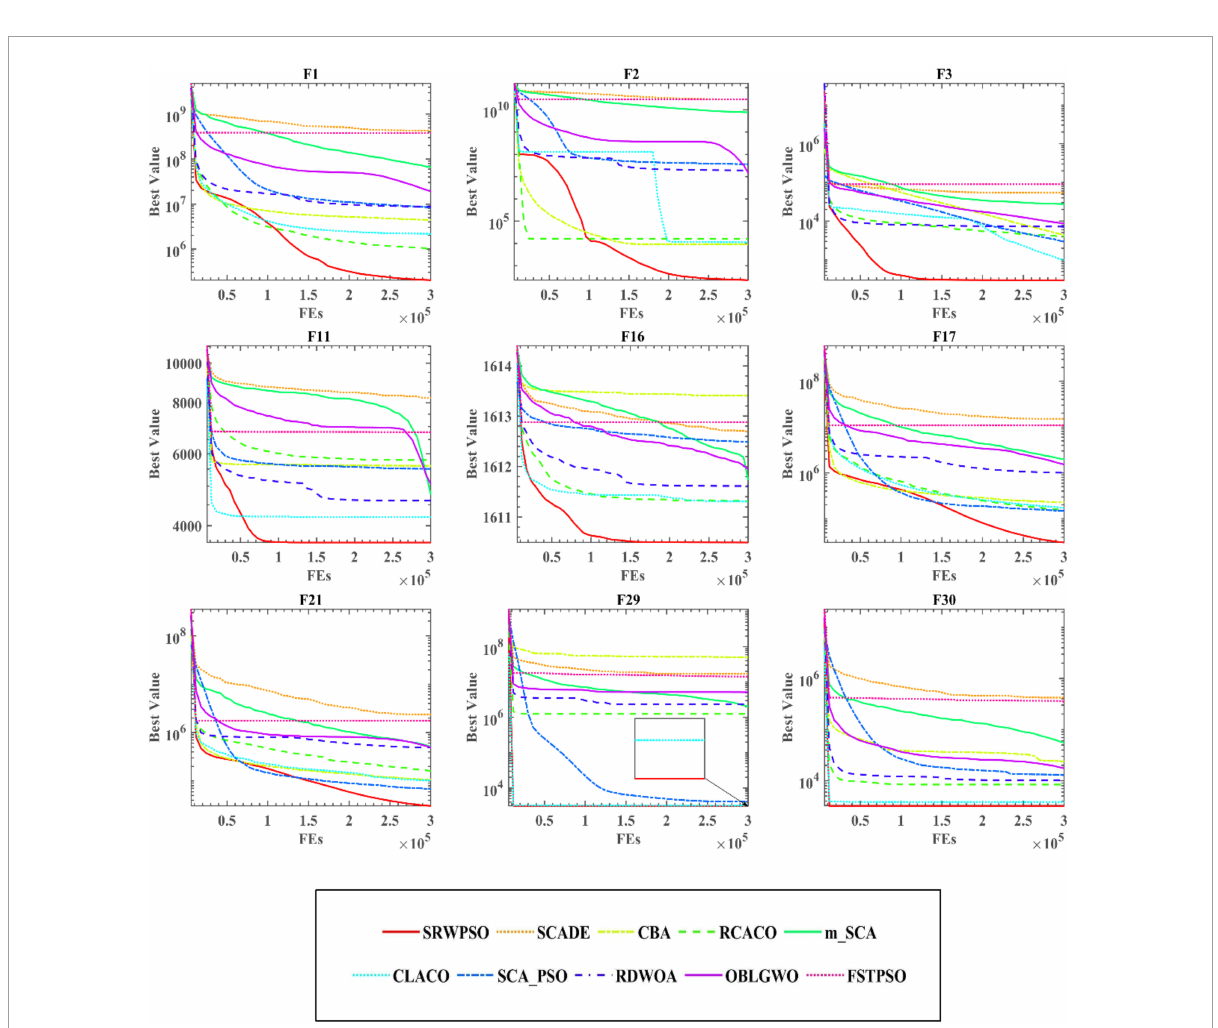
FIGURE11 The convergence curves of SRWPSO with famous